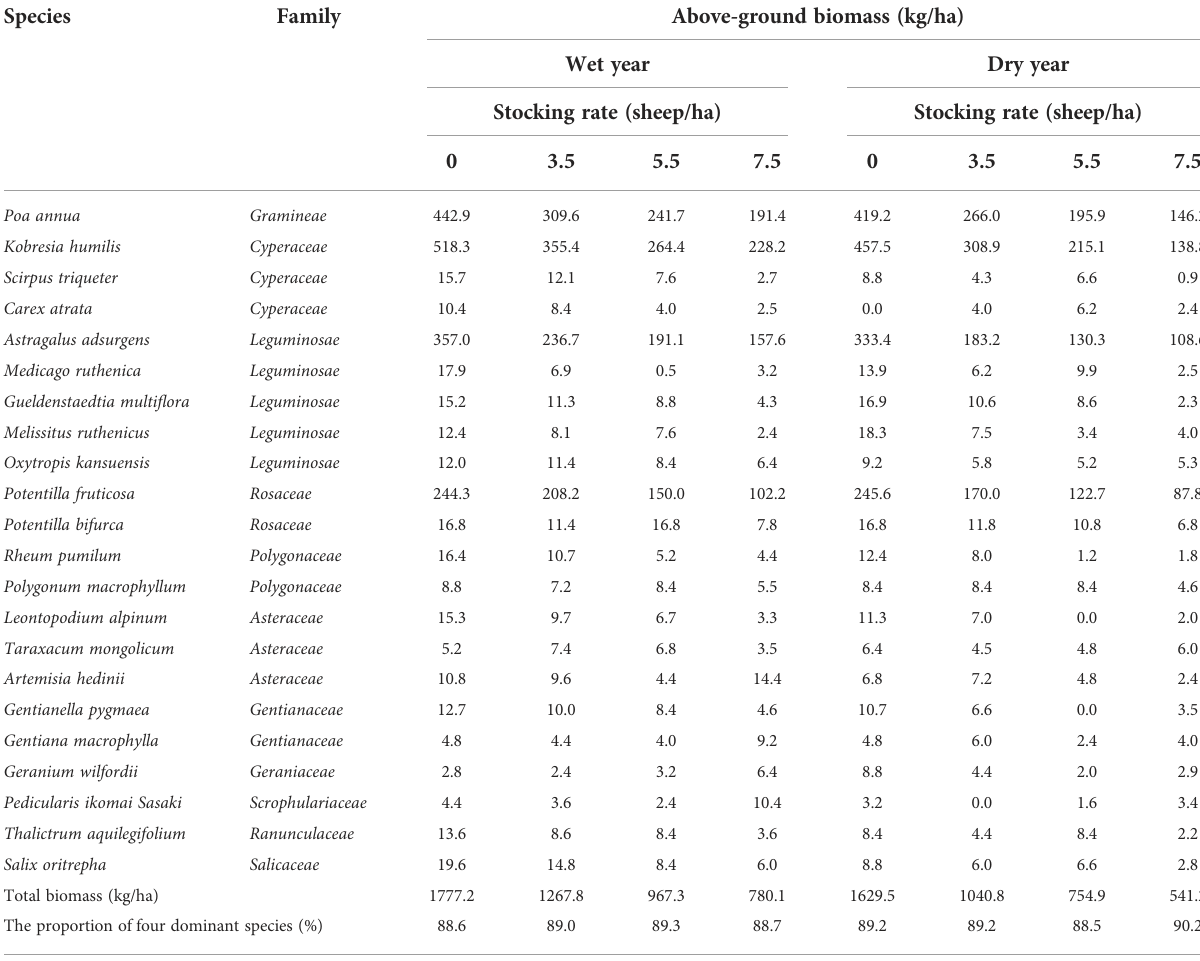
TABLE 1 Species and average above-ground biomass (kg/ha) for each plant species at each stocking rate in a wet year (2019) and a dry year (2020).